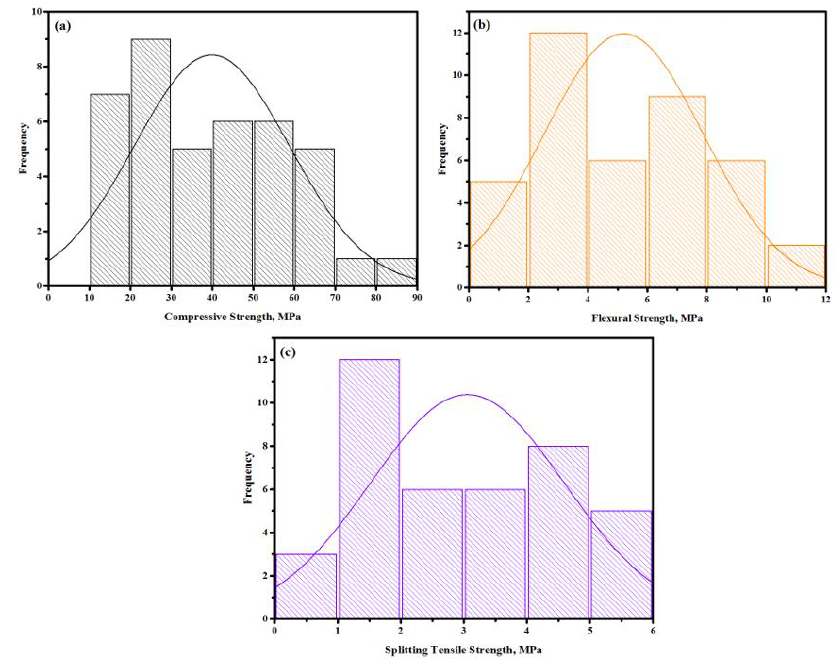
Figure 10. Histograms of strength properties of geopolymers prepared with high volume of TCWs ( a ) compressive strength ( b ) flexural strength ( c ) splitting tensile strength.